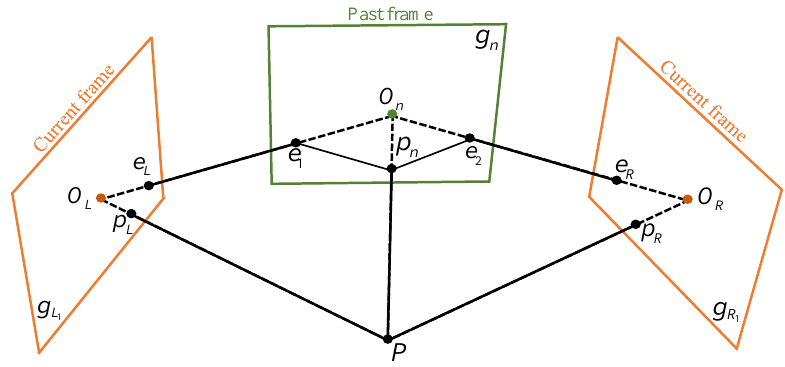
Figure 5. Corresponding-point-matching